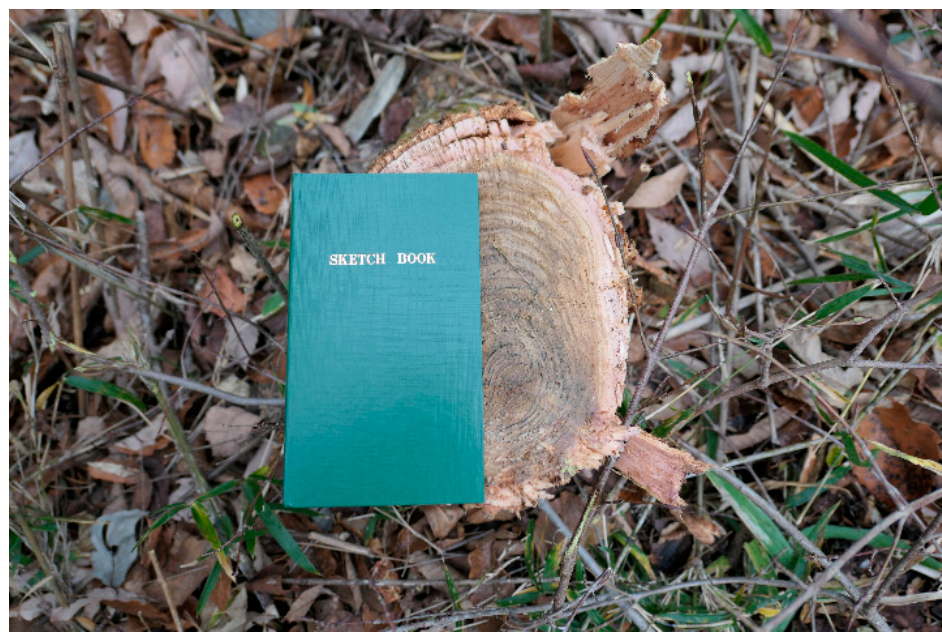
Figure 5. Cut end of a stump of which the diameter at ground level was 20 cm. The maximum reach of the felling head used in the experiment, L , was 6.7 m, so that the machine could fell a maximum of six trees inward in a row from a 3 m wide forest road (width taken into consideration) in the model forest. With respect to the other parameters acquired from the time study, the time for installation and withdrawal, a , the time for felling a tree, f , the moving velocity of the felling head, v , and the maximum number of trees that could be held at a time, h , were set to be 270 s, 10 s, 0.57 m/s and 8, respectively, based on Table 3. The simulation model for calculating the cycle time of the harvesting operation was completed assuming that the machine’s moving velocity, b , and the time for chipping, c , were 5 m/s and 10 s [27], respectively; thus, the productivity of harvesting could be calculated. Finally, the harvesting cost per BDT of small-diameter trees, HC ( L , n ) of Equation (2), was calculated by dividing the sum of the hourly costs of the two machines (listed in Tables 4 and 5 as 12,250 JPY/h (= 7173 JPY/h for the first machine plus 5077 JPY/h for the second machine), by the harvesting productivity, HP ( L , n ), calculated from Equation (1).